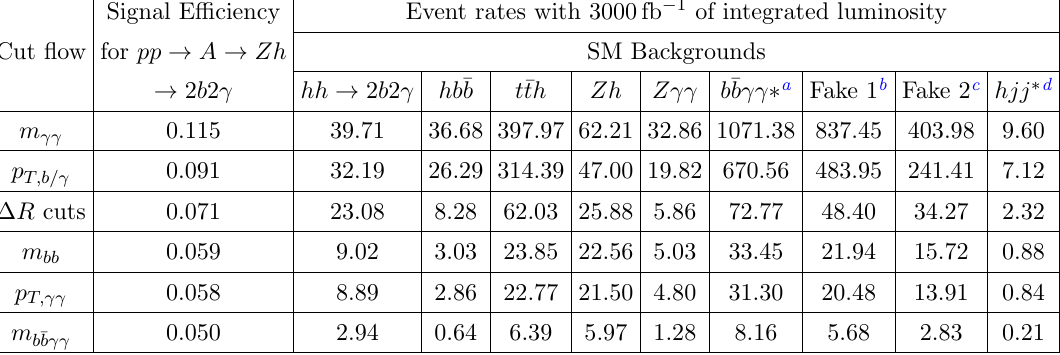
Table 7 . The cut-(cid:13)ow table for a pseudoscalar mass of 400 GeV. The various perturbative orders used in the calculations are the same as in table 4.